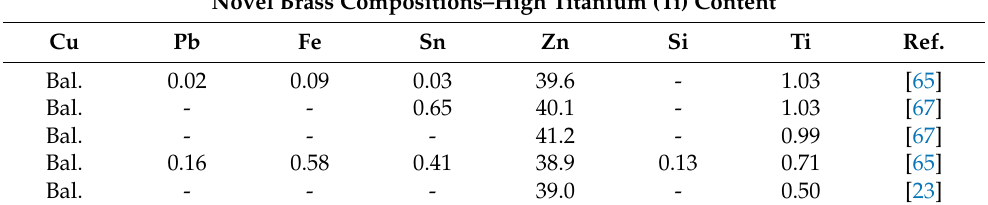
Table A7. Novel brass compositions with an increased titanium (Ti) content (alloying elements expressed in